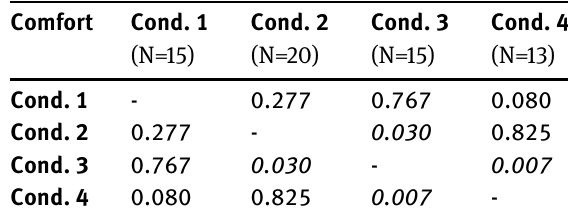
Table 5: p-values from post hoc tests for levels of comfort (F = 4.967,